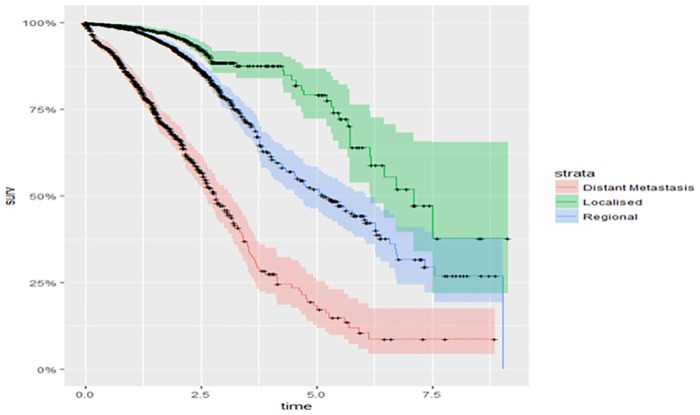
Kaplan-Meier survival probability on patients with extent or stage of the cancer.